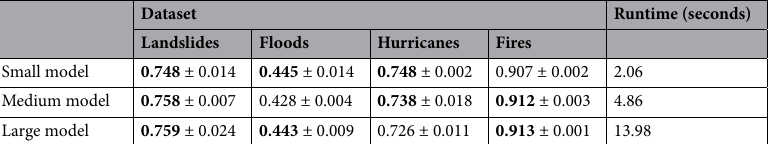
Table 5. AUPRC and timings for different sizes of model (averaged over 5 runs). The AUPRC results are for the cosine similarity of the embedding with a history of 3 frames. Runtime is measured on-board of the Xilinx Pynq